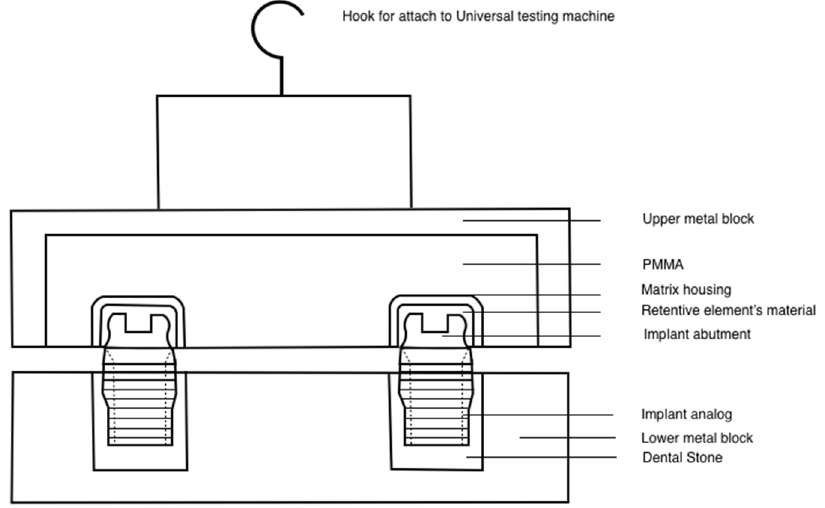
Figure 3. Schematics of the specimen attachment to the universal testing machine.